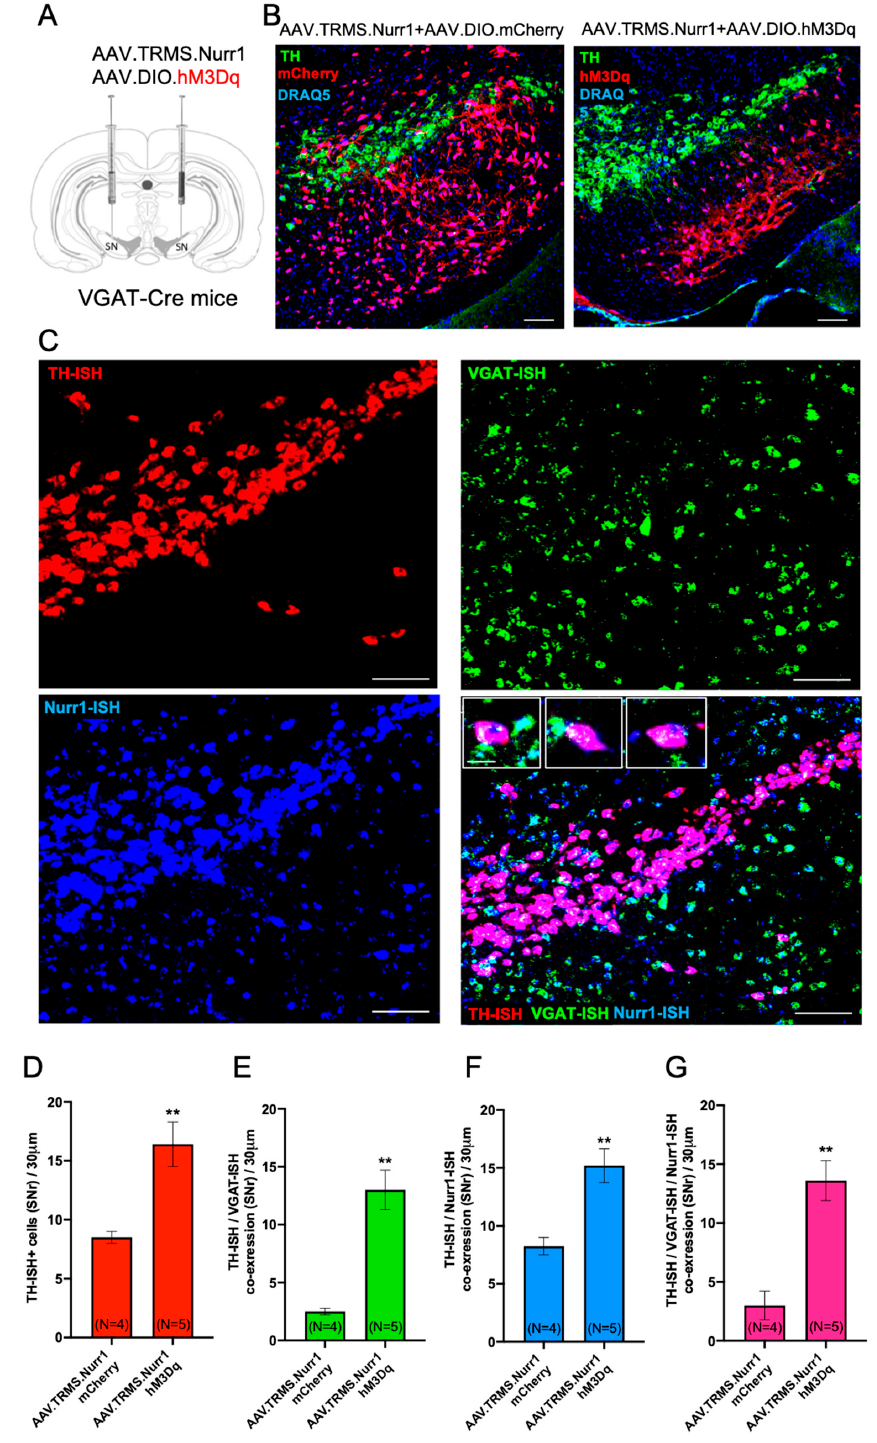
Figure 9. Effect of concomitant chemogenetic activation of SN GABAergic neurons and Nurr1 up- regulation on TH phenotype. ( A ) Schematic representation of the viral strategy adopted to chemo- genetically activate VGAT+ neurons and overexpress Nurr1 in the SN of VGAT-Cre mice by bilat- erally injecting a Cre-dependent DREADD (hM3Dq).mCherry AAV and pan-neuronal Nurr1 viral vector (AAV5.TRMS.Nurr1). ( B ) Confocal images of representative SN sections (30 μ m) showing